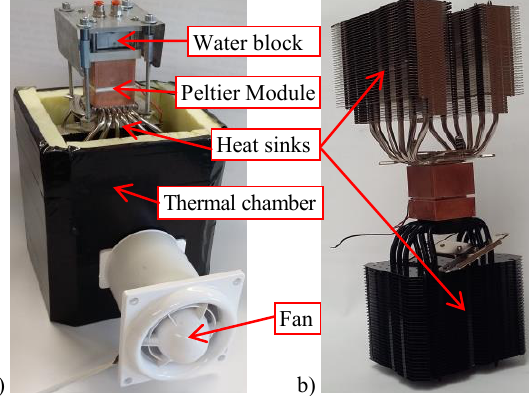
Fig. 1. Cooling and heating system with: a) heat sink and water block, b) two heat sinks